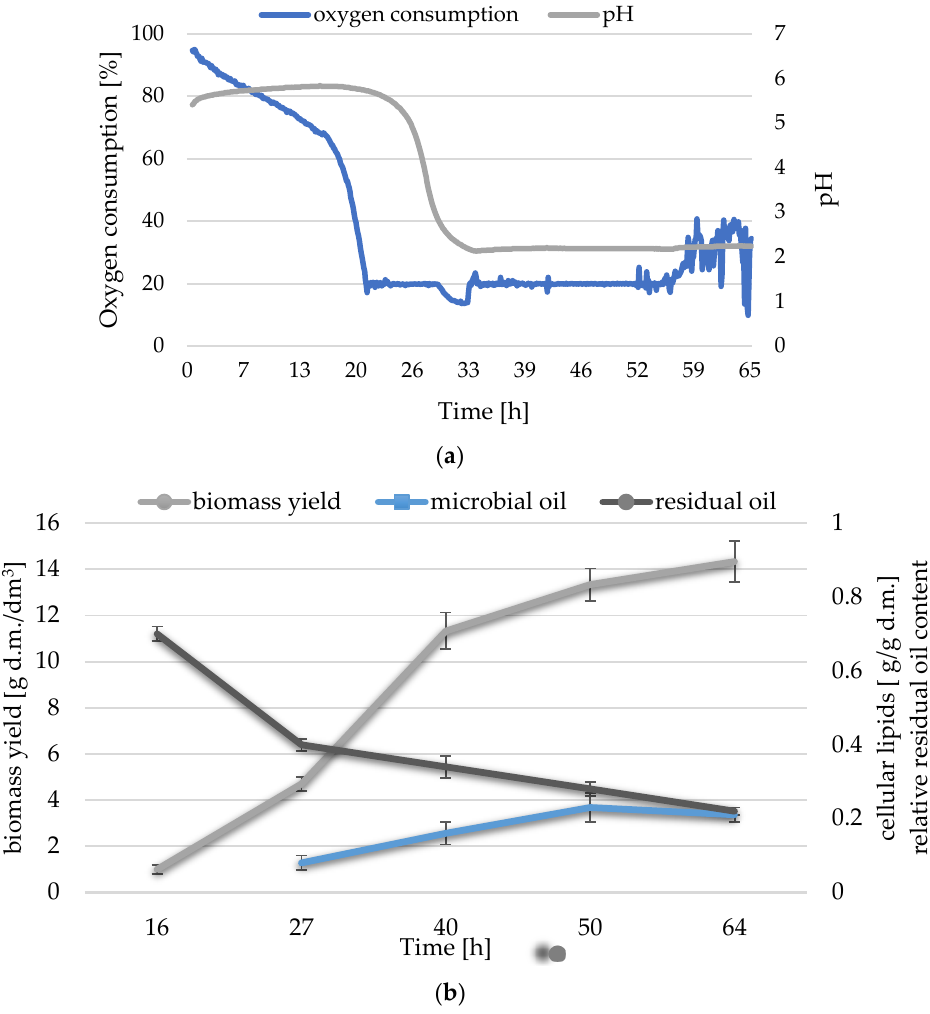
Figure 2. Changes in ( a ) pH and oxygen consumption and ( b ) biomass yield, cellular lipids content and relative residual oil content during a batch culture of Y. lipolytica in medium D-pfWO-N-0.25- Aer-reg.